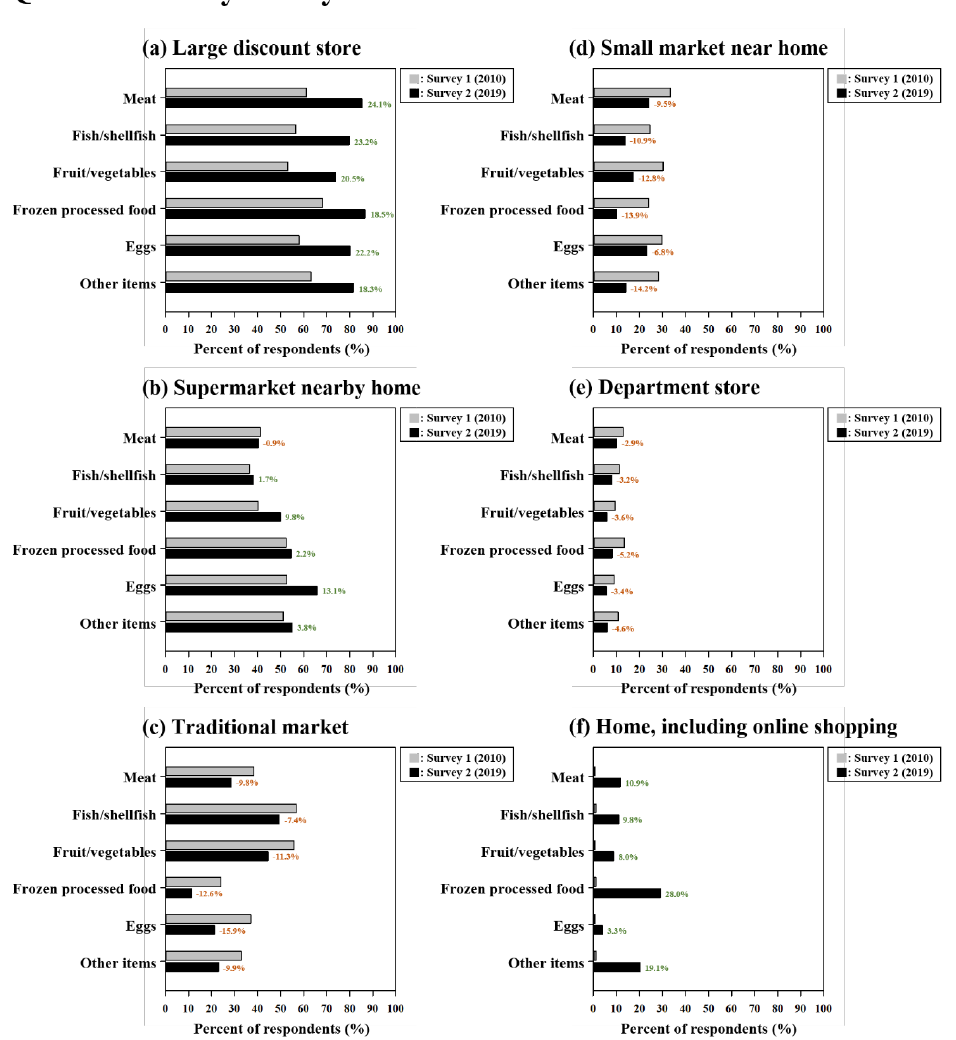
Figure 1. Purchasing places for meat, fish / shellfish, fruit / vegetables, frozen processed foods, eggs, and other items: ( a ) Large discount store, ( b ) Supermarket nearby home, ( c ) Traditional market, ( d ) Small market near home, ( e ) Department store, ( f ) Home, including online shopping.